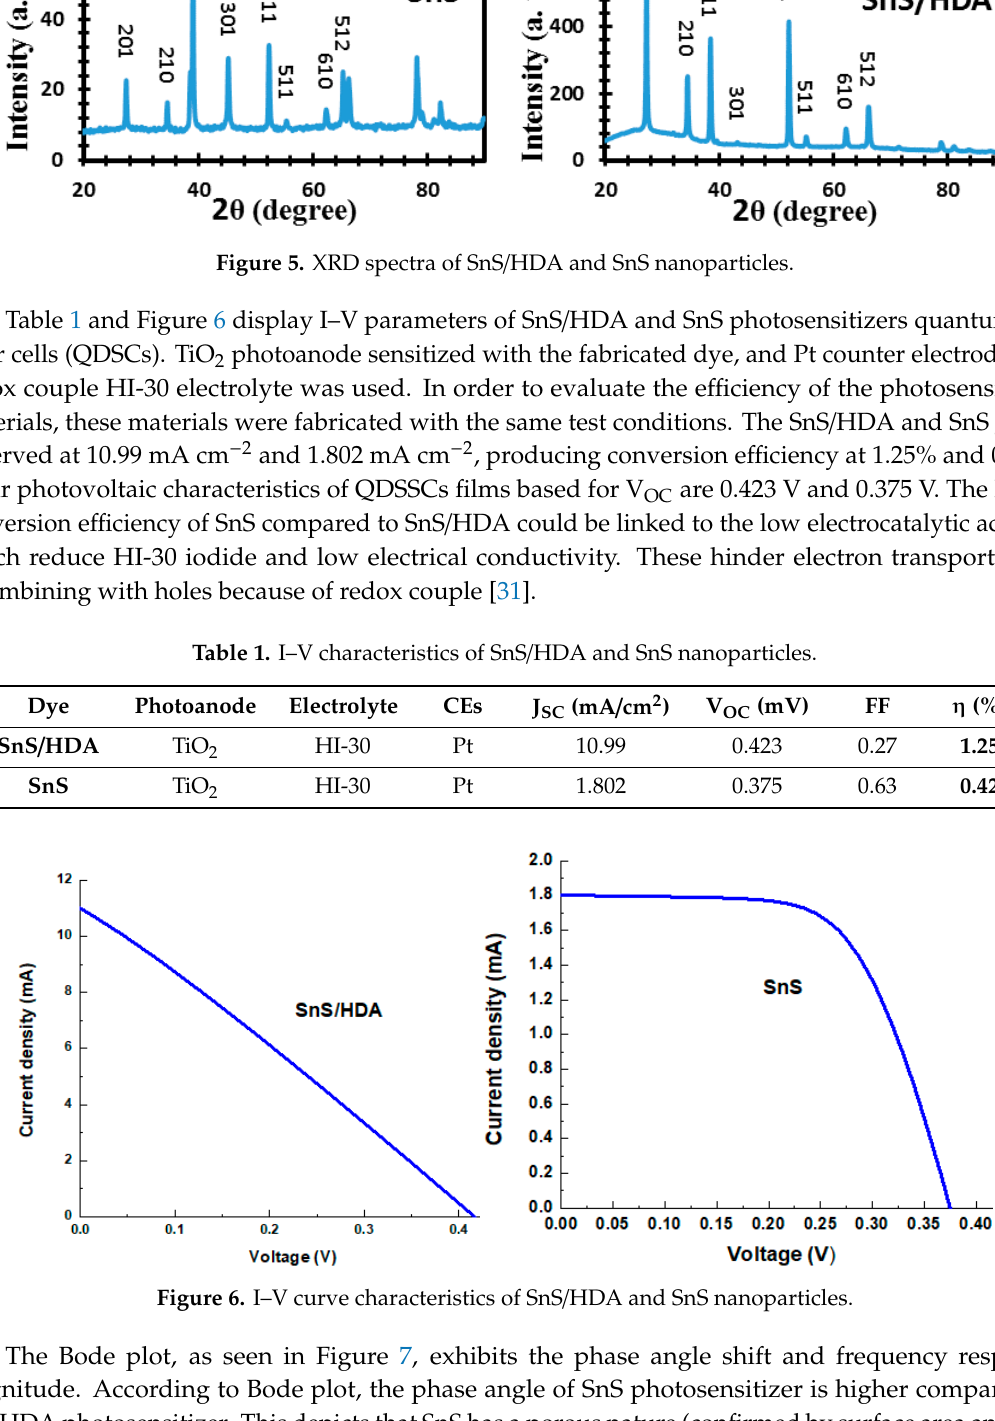
Figure 7. Bode plot spectra of SnS/HDA and SnS nanoparticles. The topographical analysis was carried out using atomic force microscope (AFM). The evaluated particles size varied in the range of 0.11–1.18 um for SnS/HDA and 0.054–0.54 um for SnS films grown at 360 °C with size height of 16.8% and 8.4%, respectively, as seen in Figure 8. These images revealed little significant changes in the particles size of both samples fabricated at the same temperature. The ad-atoms move over the surface brings bonding togetherness with an enlarged form of sub-particles. This emanated to formation good compactness and larger particles size. When the film surface is smooth, it resulted to lower roughness due to high surface diffusion [33]. This can be attributed to better particle size and good power conversion efficiency in QDSSCs, which depends solely on the low roughness of the photoelectrodes.